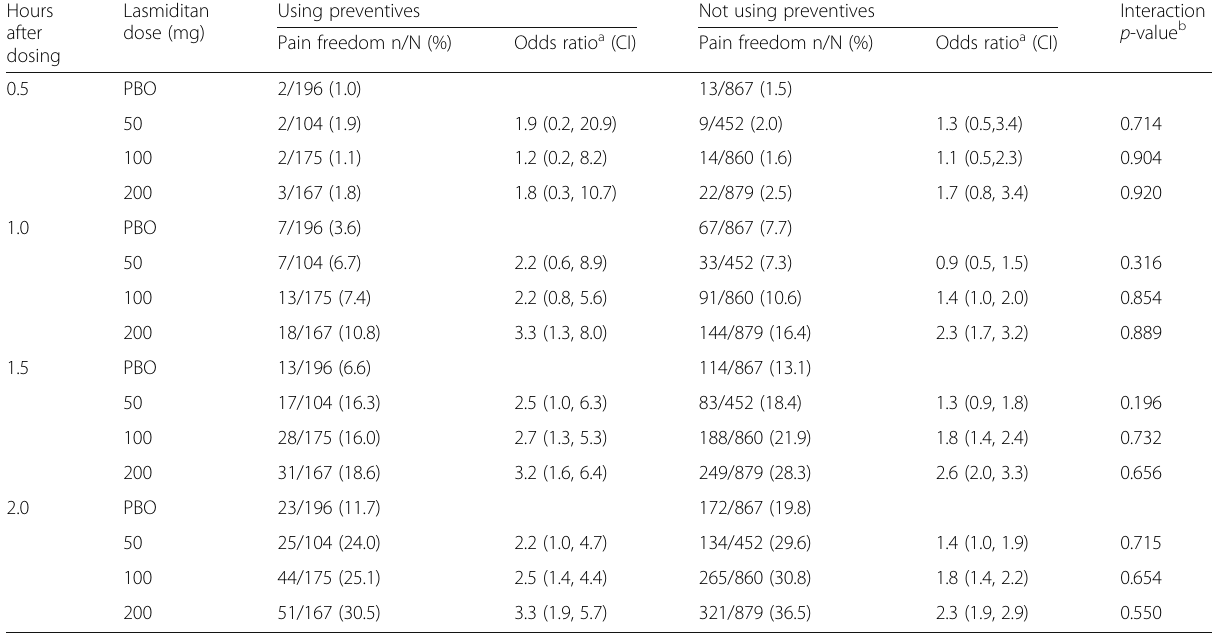
Table 5 Pain freedom at 0.5, 1, 1.5, and 2 h did not differ significantly between groups using and not using migraine preventive medications